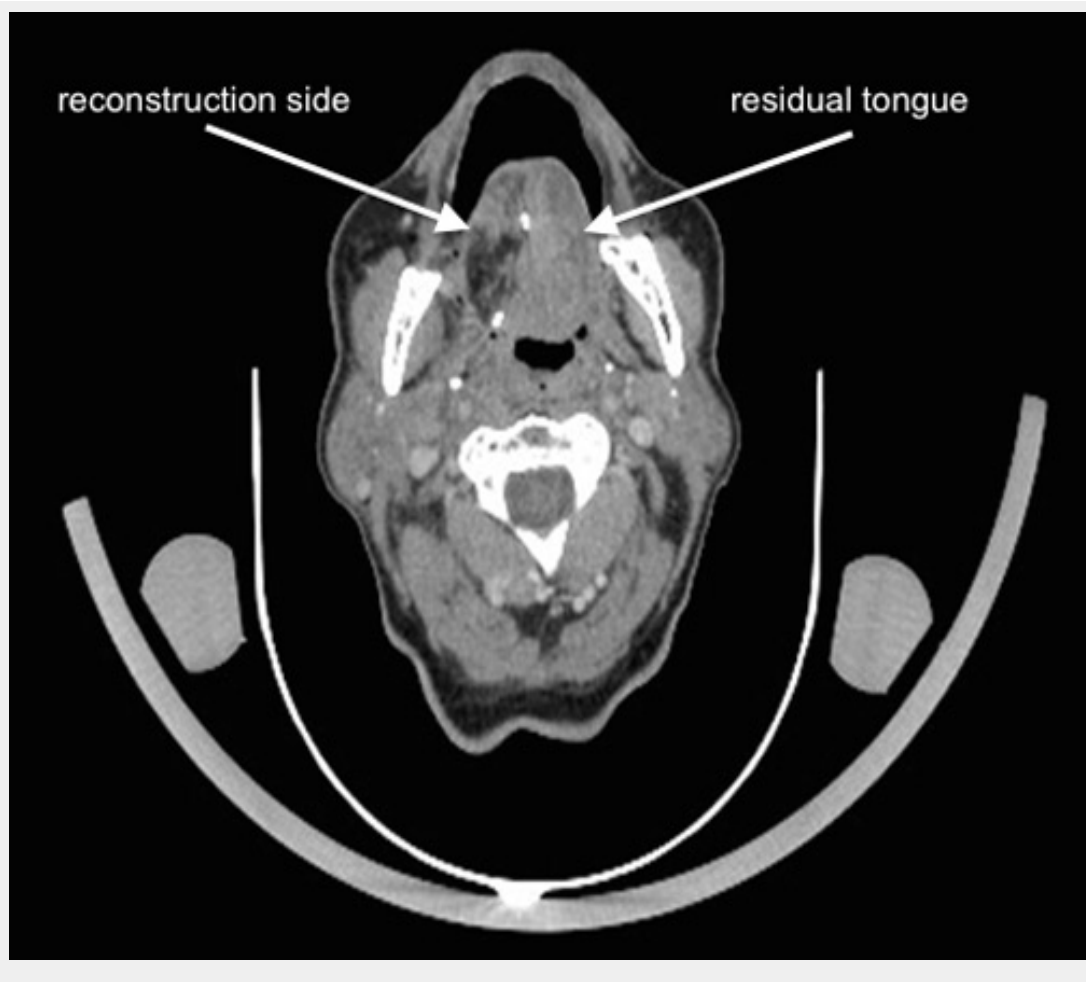
Figure 2 Follow-up contrast enhanced computed tomography part from a 18F-FDG-PET/CT scan 6 months following right partial glossectomy, elective neck dissection and reconstruction of the tongue with a radial forearm free flap for a pT2 pN1 squamous cell carcinoma. The primary site cannot be evaluated exactly regarding local recurrence. There are no evident suspicious lymph nodes to be